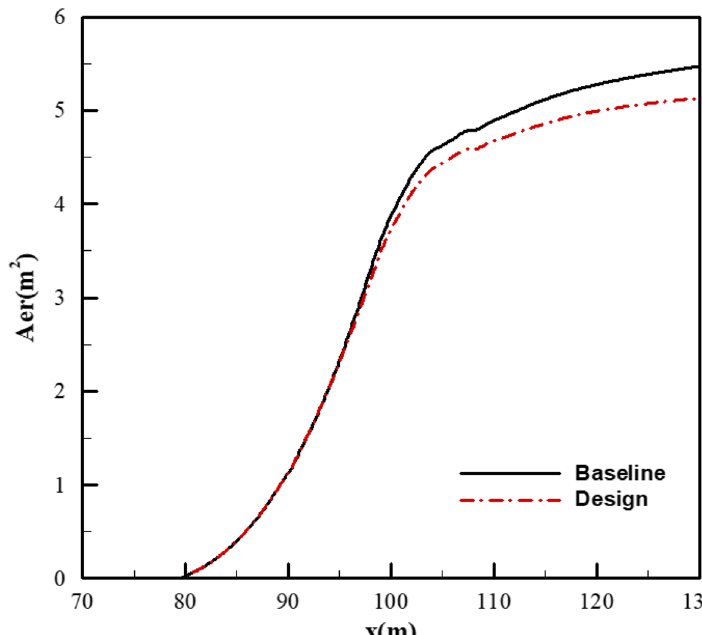
Fig. 18 Comparison of equivalent area